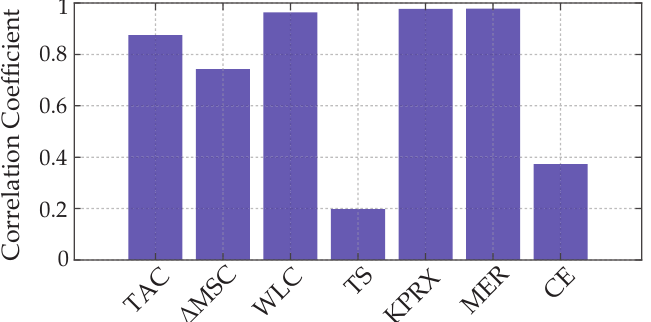
Figure 12. Correlation coefficient between floorwise evaluation of DSFs and a damage index ( DI PA ). Except for TS and CE , which evaluate the energy accumulation over time, a good correlation between the locally evaluated DSFs and the floorwise damage is